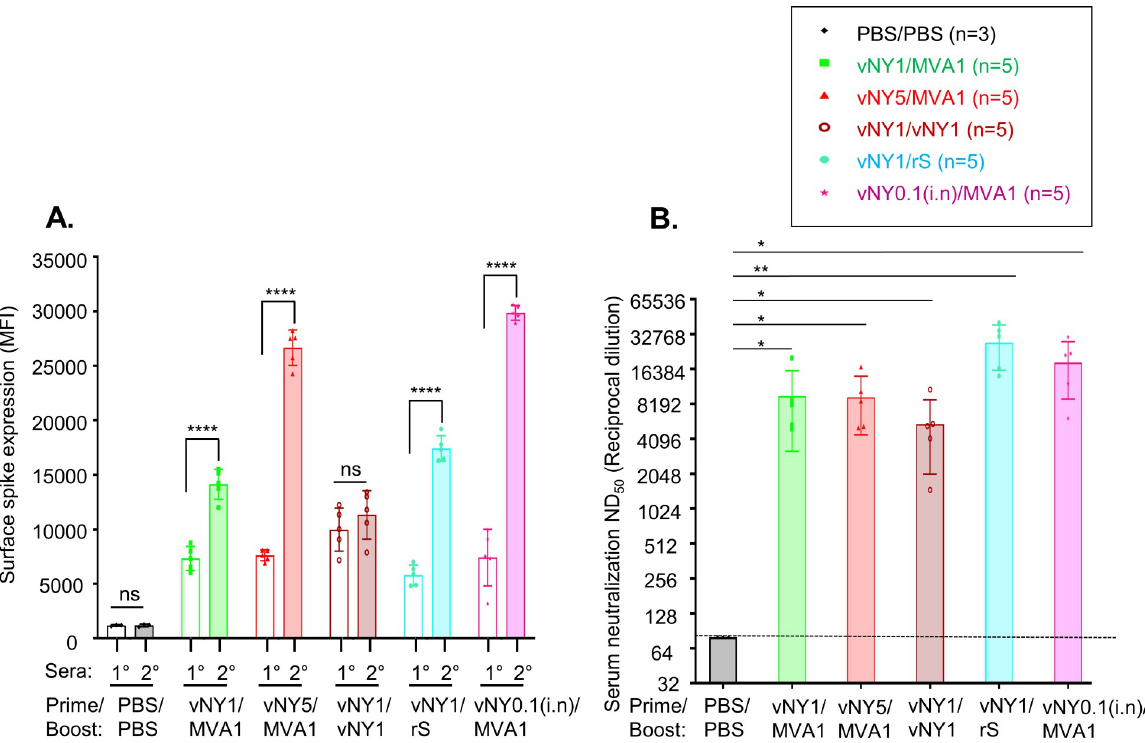
Fig 9. Heterologous prime-boost and intranasal inoculation with v-NY-S enhances production of SARS-CoV-2 spike-specific neutralizing antibodies. (A). Quantification of anti-spike antibody titers in primary (1˚, transparent bars) and secondary (2˚, filled bars) sera from mice by staining cell surface spike protein on insect cells using FACS, as shown by the mean fluorescence intensity (MFI). Sera were collected from identical mice after prime (1˚) and boost (2˚). Numbers of mice in each prime-boost groups are shown on top of the figure. Data are represented as mean ± SD. ���� p < 0.0001; ns-not significant. (B). SARS-CoV-2 pseudotyped virus neutralization assays for 2˚ sera collected from mice after different prime-boost regimens. The dotted line represents assay limit of detection. rS: recombinant spike protein. � p < 0.05; �� p < 0.01.